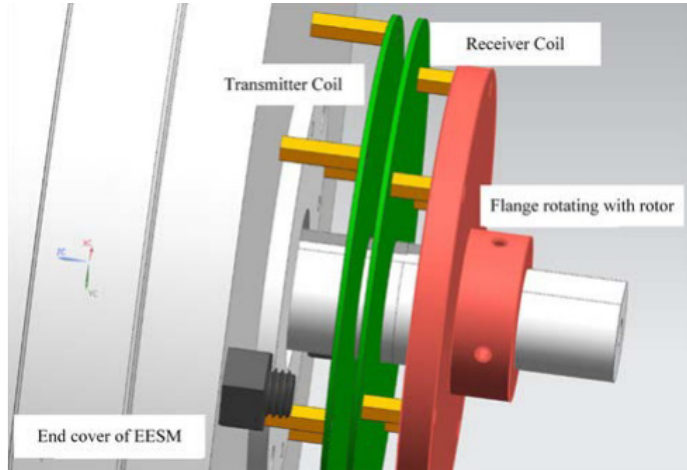
Figure 2. Assembly diagram of the contactless excitation system.